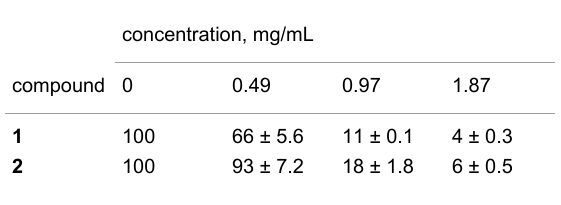
Table 8: Viability (%) of F. neoformans IGC 3957 treated with com- pounds 1 and 2 at pH 4.0. concentration, mg/mL